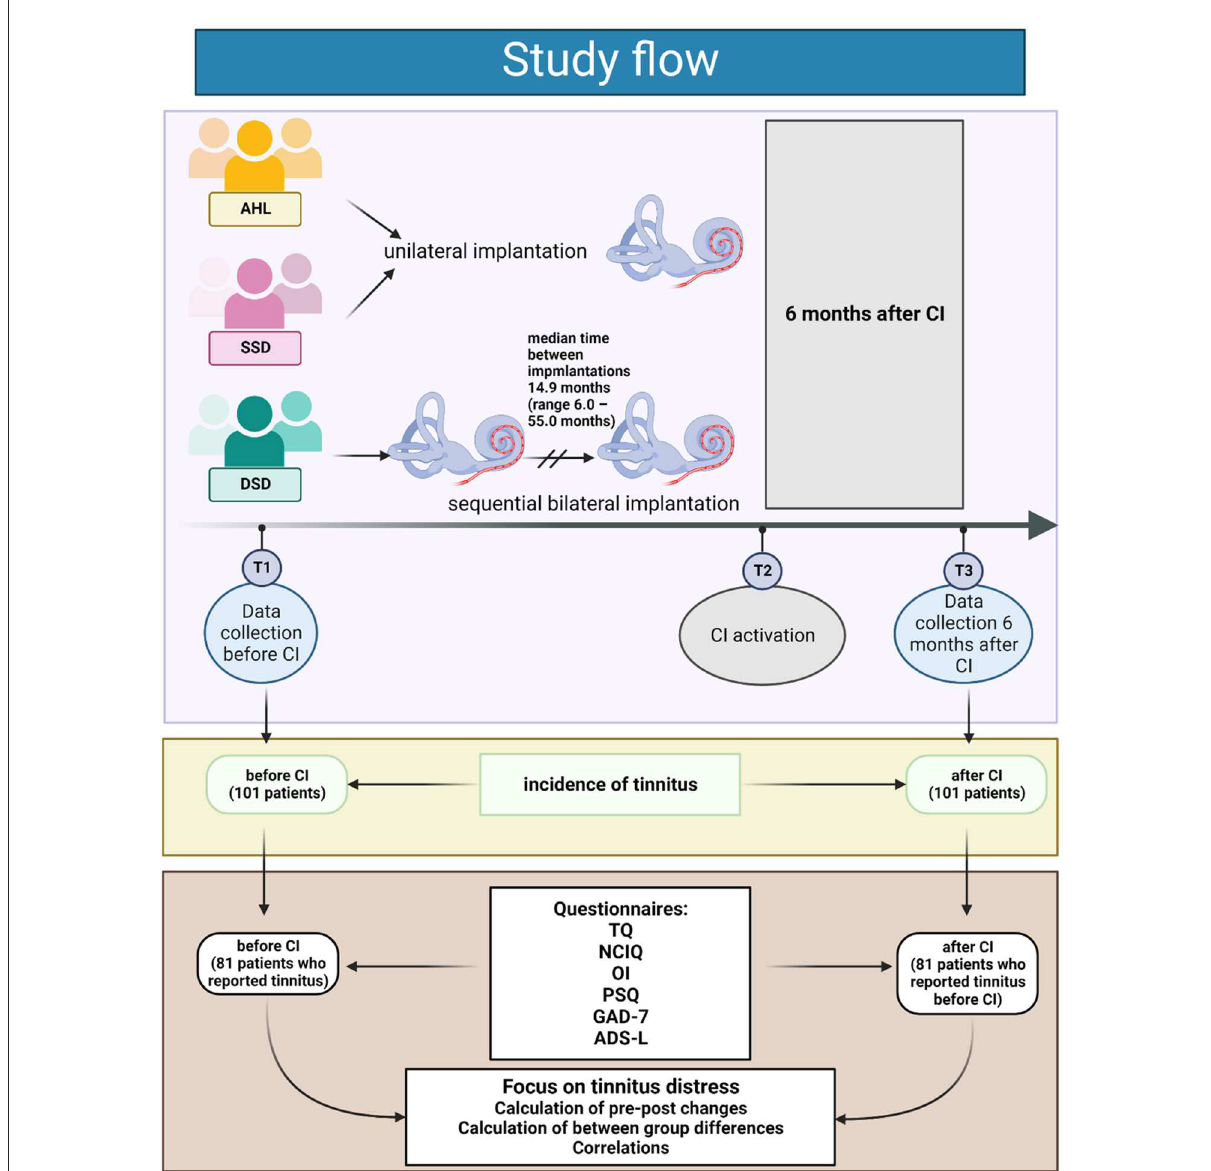
FIGURE1 The data was collected from all patients at the study baseline (T1). Only the patients with tinnitus were included in further analysis. T2 indicates the time at which the patients in all groups had their CI activated. The second data set was collected at T3 (six months after activation of